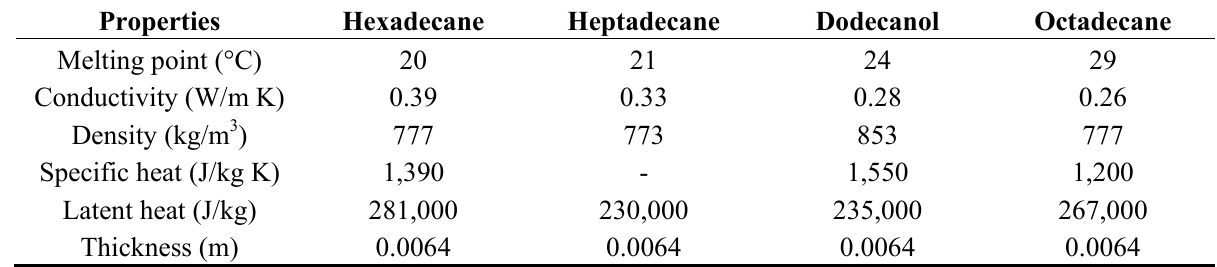
Table 1. Physical properties of phase change materials (PCMs).